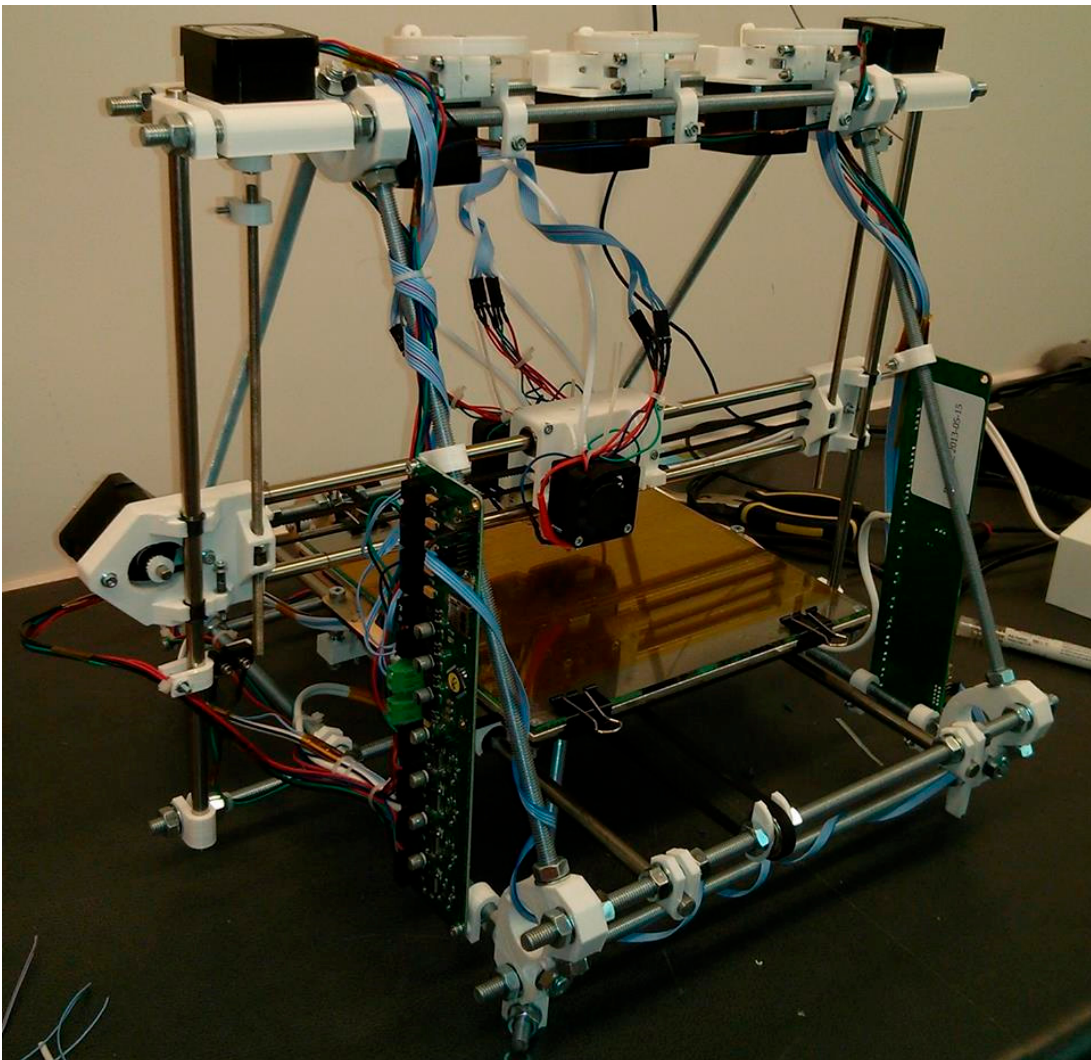
Figure 2. RepRap 3D printer comprising a Cartesian robot with extruder head.